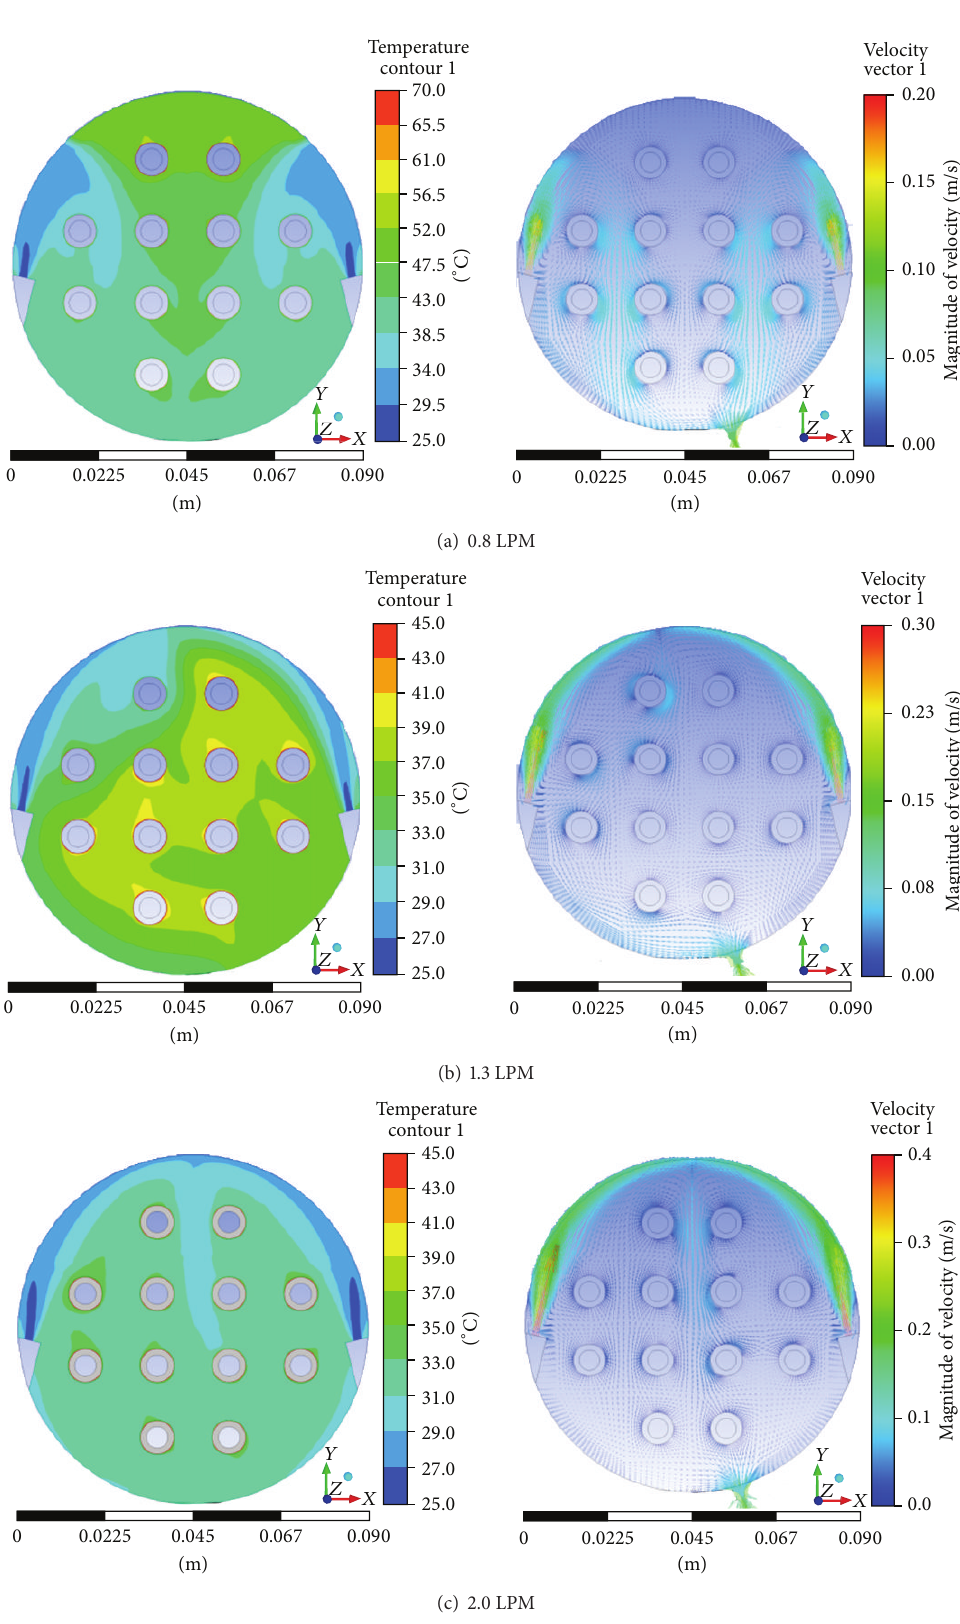
Figure 5: Temperature (left) and flow distributions (right) according to the flow boundary conditions in the CFD